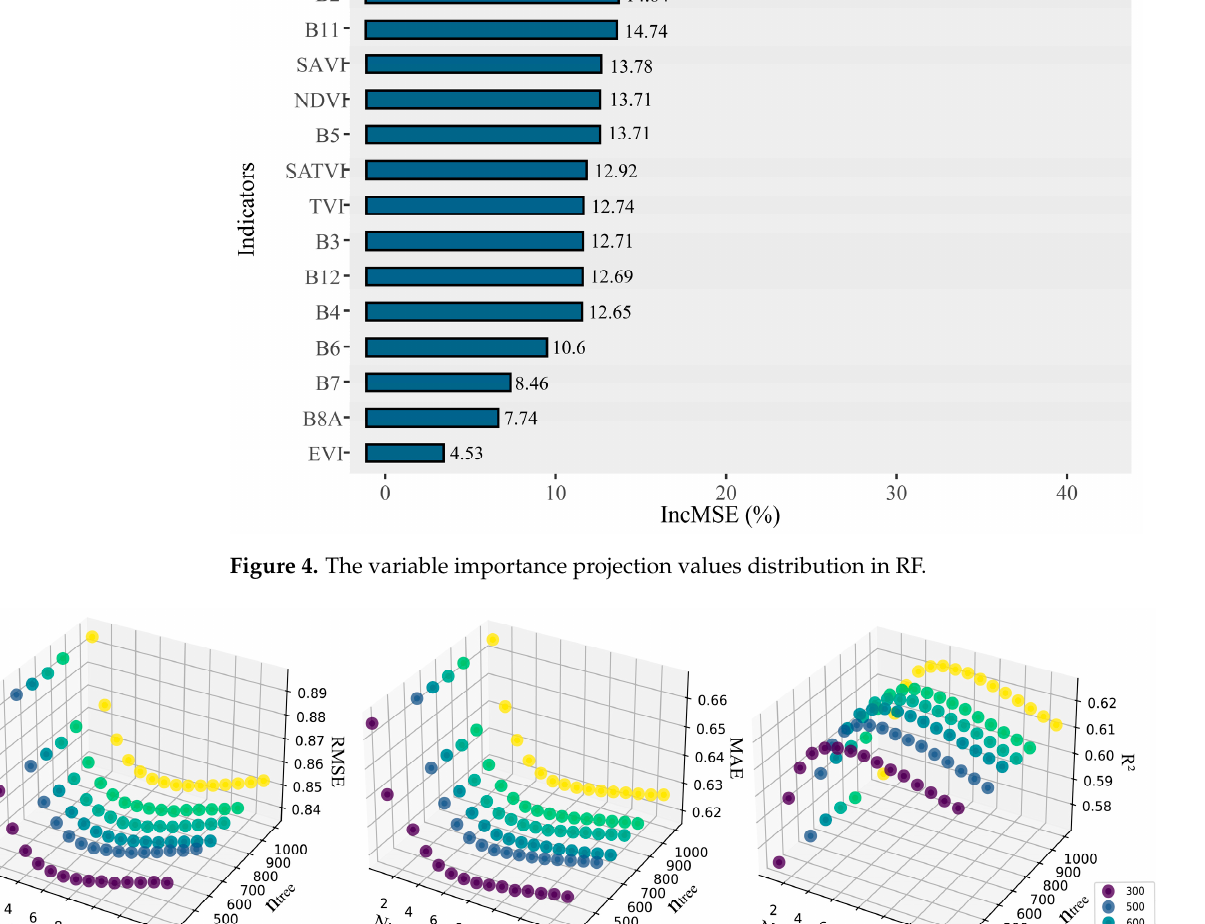
Figure 5. RF accuracy during the variable selection process using the different numerous trees (n tree ).